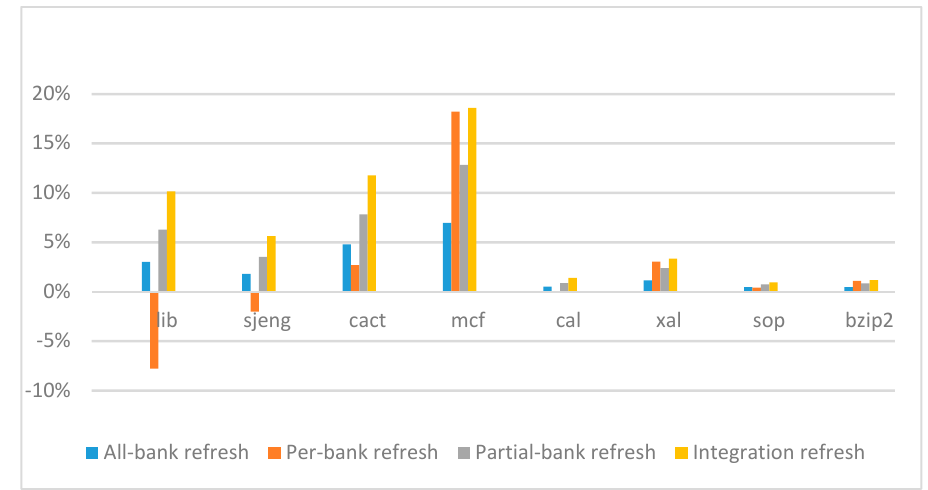
Figure 14. Instructions-per-clock (IPC) improvement normalized to 1x granularity baseline (tRFC = 530 ns, weak row = 1%).